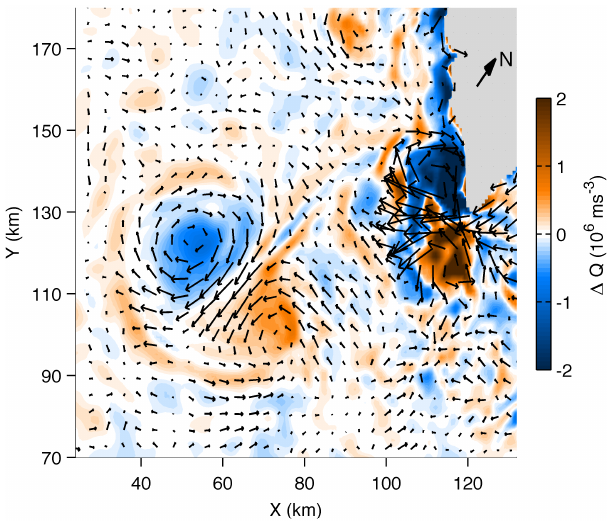
Fig. 4. Vertically integrated potential vorticity for day 31 of a tidal model run. Vorticity anomalies are concentrated at the cape, but a mesoscale vortex dipole has organized and is propagating south